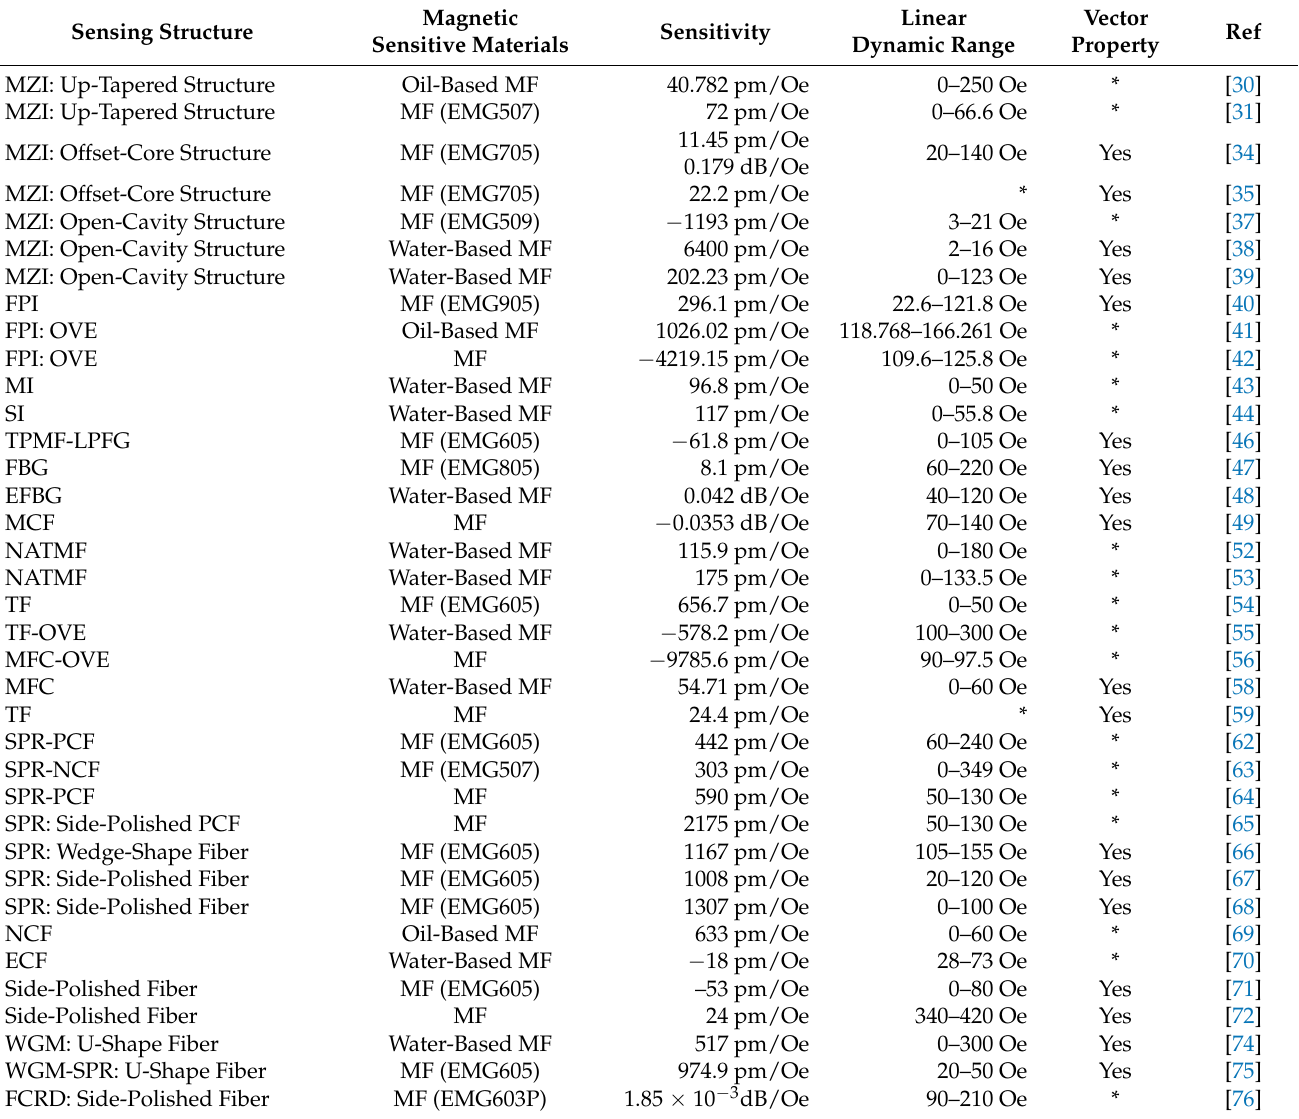
Table A1. Main performance parameters of magnetic field fiber sensors based on